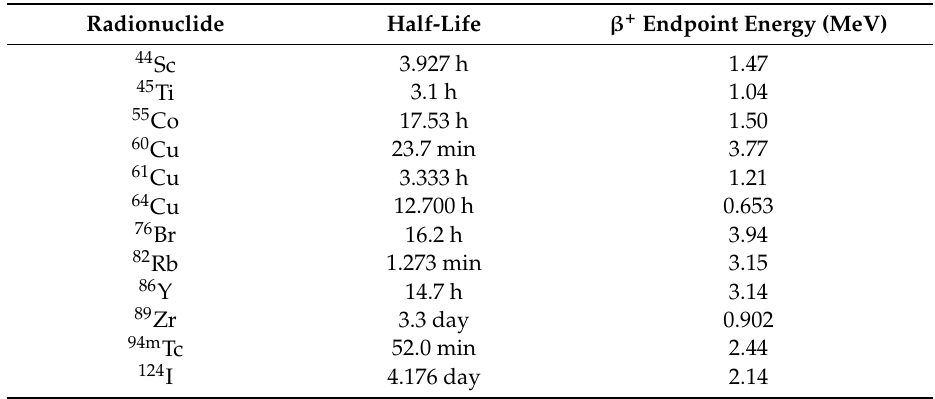
Table 1. Some unconventional positron emission tomography (PET) radionuclides and corresponding physical properties